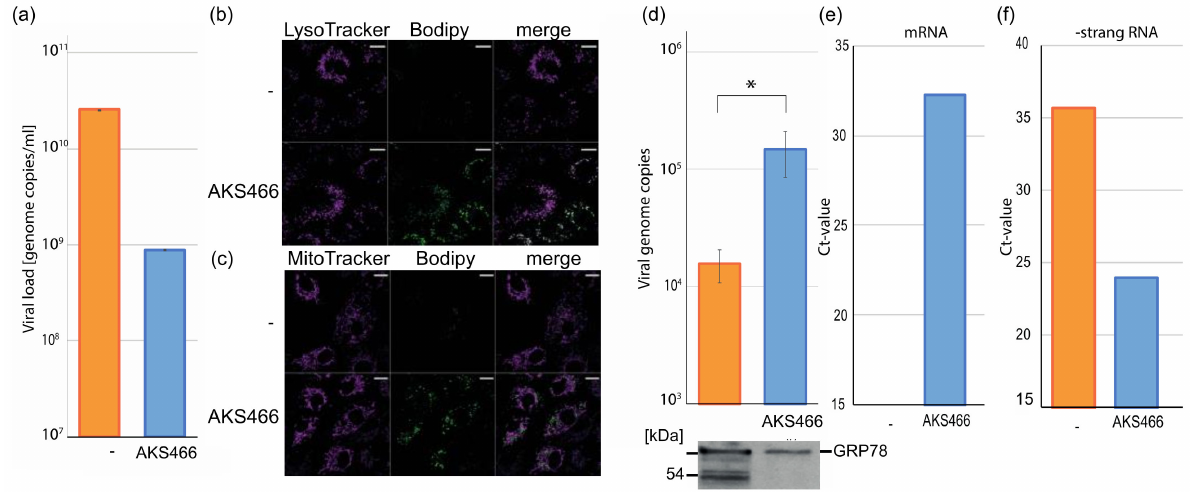
Figure 4. AKS466 is localized in lysosomes and inhibits the release of SARS-CoV-2. ( a ) AKS466 reduces the viral RNA concentration in the cells. Cells were treated and infected with AKS466, cellular RNAs were isolated, and viral transcripts were quantified by RTqPCR. ( b , c ) Cells were incubated with 15 µ M of AKS466 for 1 h and labelled with 4 µ M DBCO-BODIPY for 15 min. Lysosomes and mitochondria were co-stained with LysoTracker ( b ) or MitoTracker ( c ), respectively. The significance was calculated with the student’s t -test. (* p < 0.005) . Cells were treated with AKS466. The subcellular localization of AKS466 was visualized by linking BODIPY with a click-reaction to AKS466. Scale bar 4 µ m ( d – f ) Huh-7 cells were treated with AKS466 and infected with SARS-CoV-2. The cells were lysed, and lysosomes were purified. ( d ) Viral RNAs, ( e ) mRNAs, and ( f ) ( − ) stranded genomic were quantified. Western blotting analyses for GRP78 served as the control for lysosomes on the egress